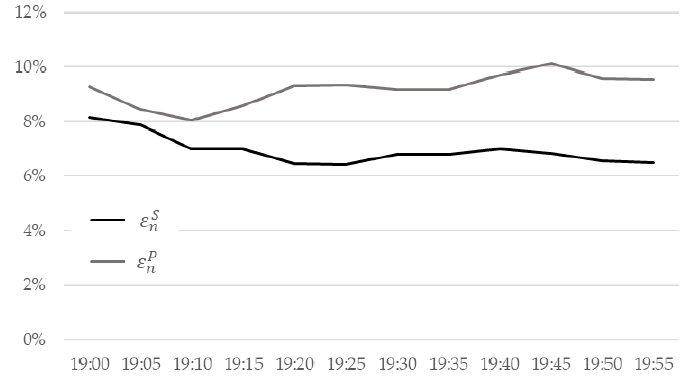
Figure 9. The (cid:2013) (cid:3041)(cid:3020) and (cid:2013) (cid:3041)(cid:3017) assuming that DERs complies a schedule determined by each iteration.